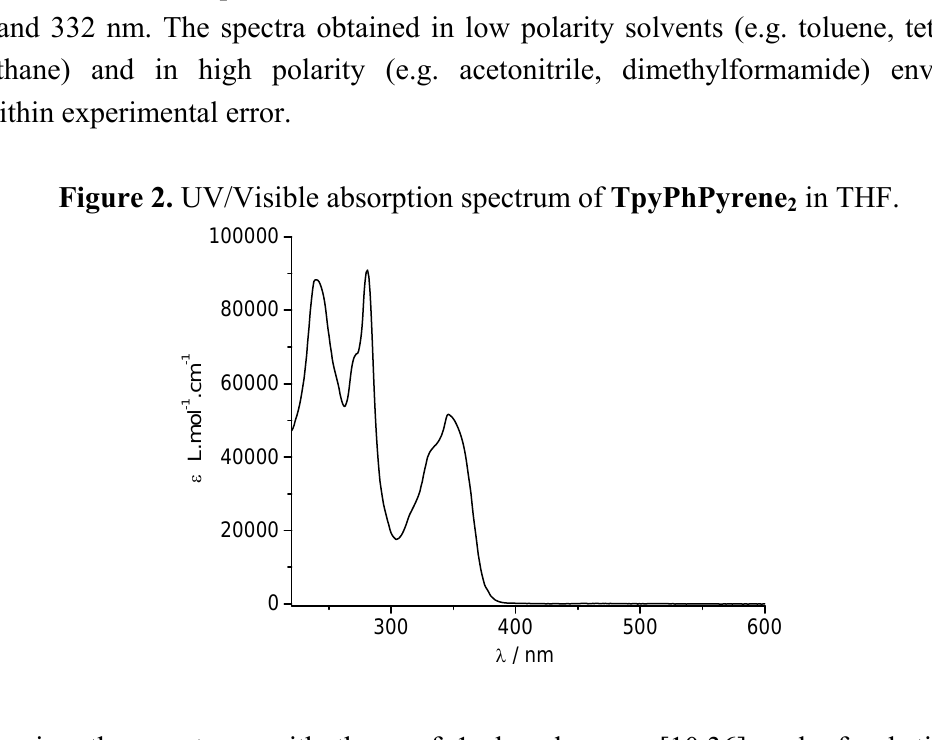
Figure 2. UV/Visible absorption spectrum of TpyPhPyrene